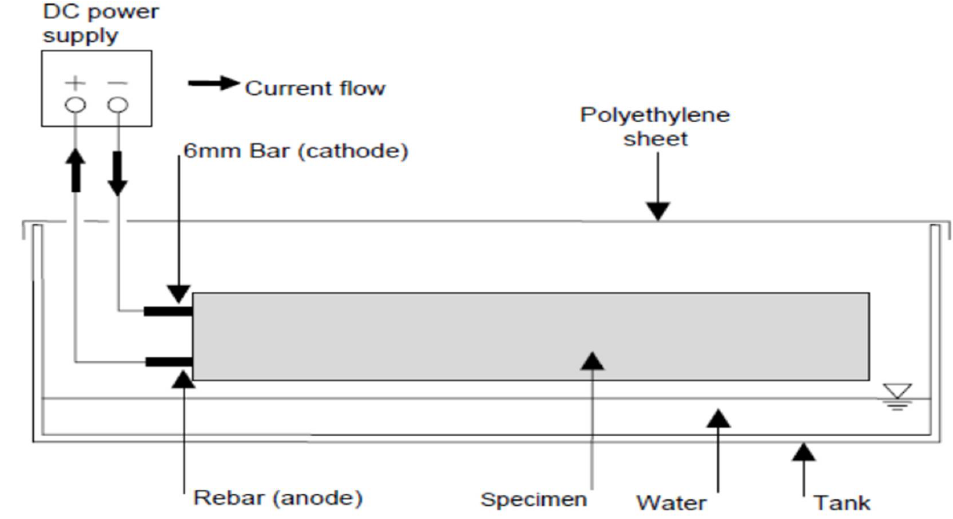
Figure 4. Schematic of accelerated corrosion set-up.